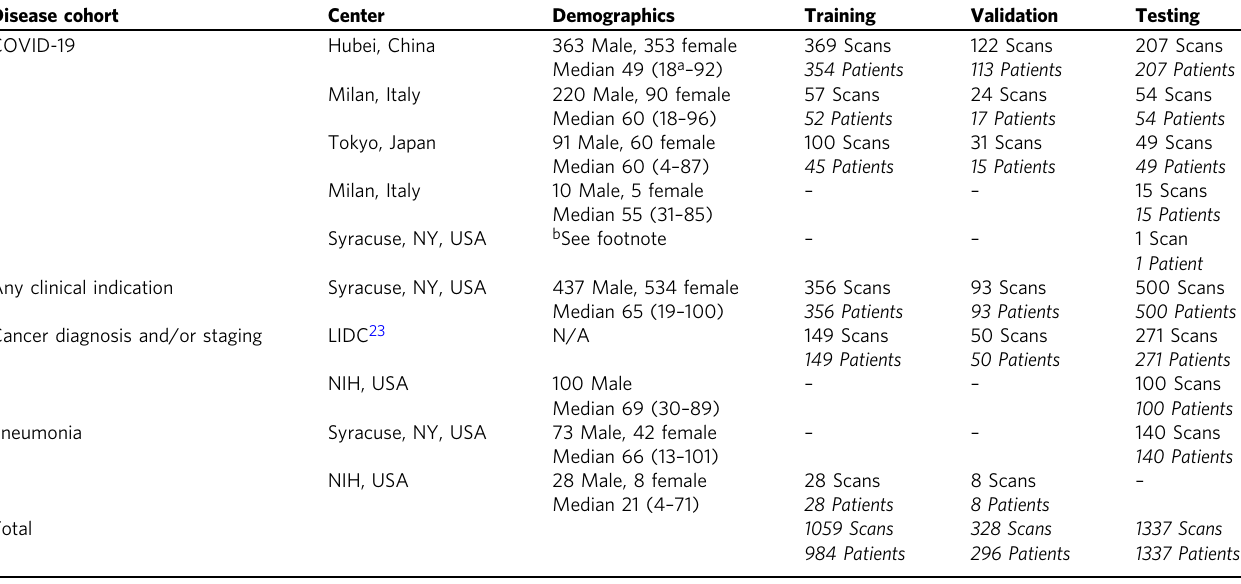
Table 1 Patient cohorts utilized in model development and testing. Demographic values are reported as absolute numbers for patient sex and as median (range) for patient